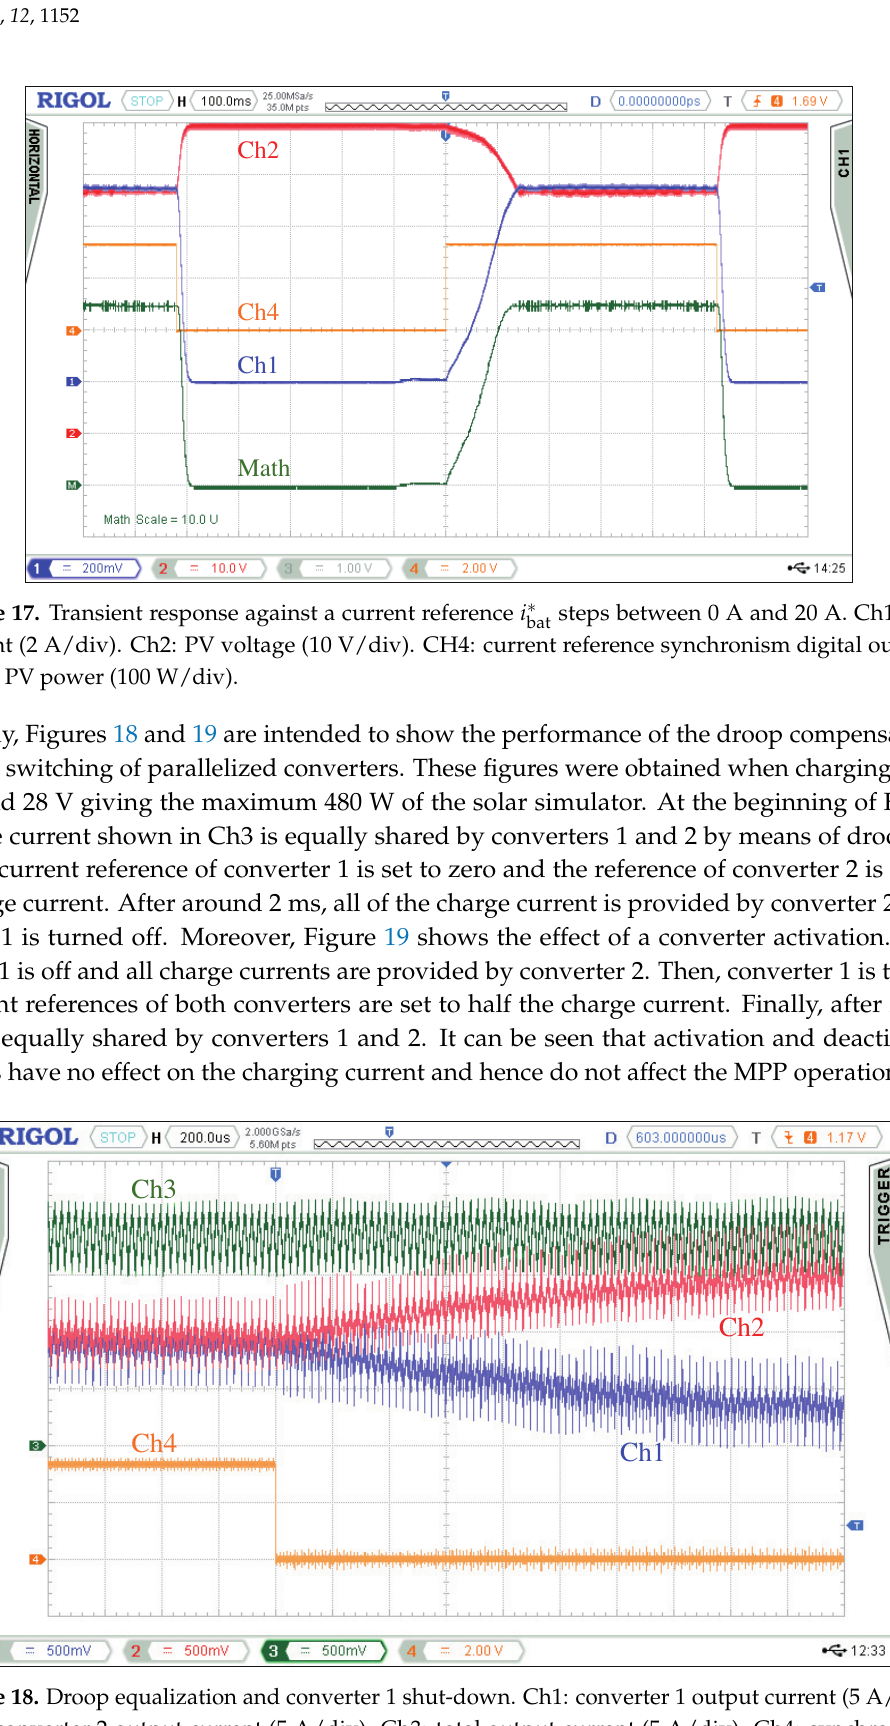
Figure 18. Droop equalization and converter 1 shut-down. Ch1: converter 1 output current (5 A/div). Ch2: converter 2 output current (5 A/div). Ch3: total output current (5 A/div). Ch4: synchronism digital